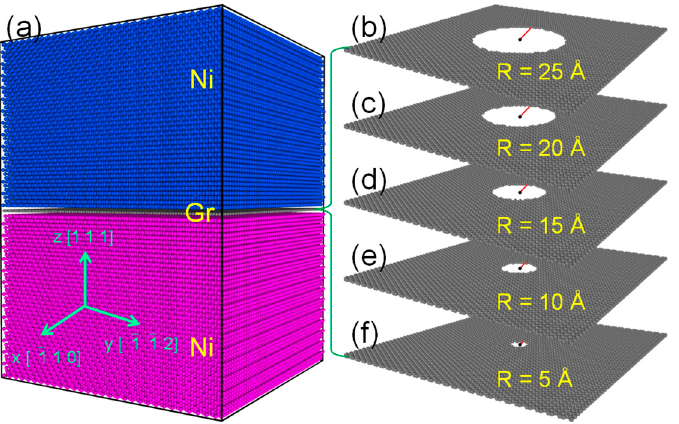
Figure 1. Simulation model for displacement cascades. ( a ) Originally atomic configuration of